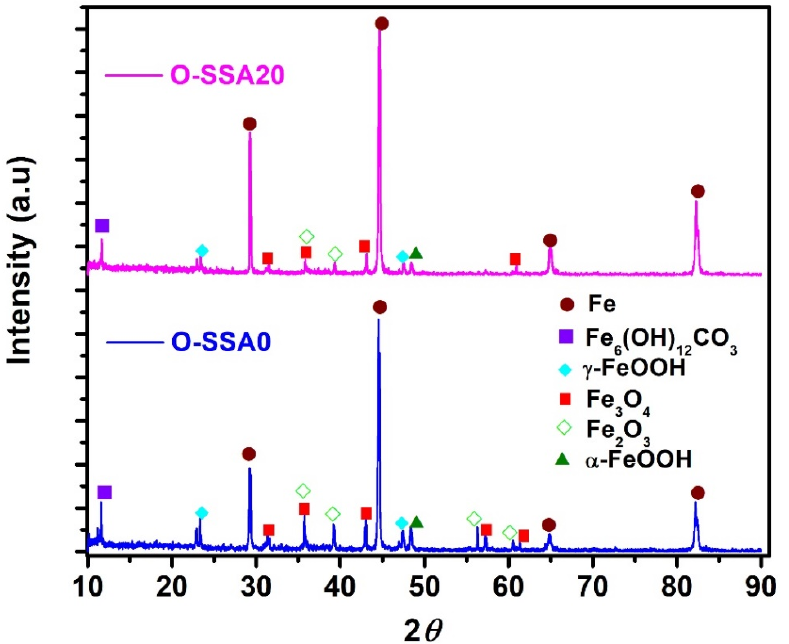
Figure 12. XRD patterns of the corrosion products on the steel rebar surface after an exposure period of 30 days [O-SSSA0 and O-SSA20].